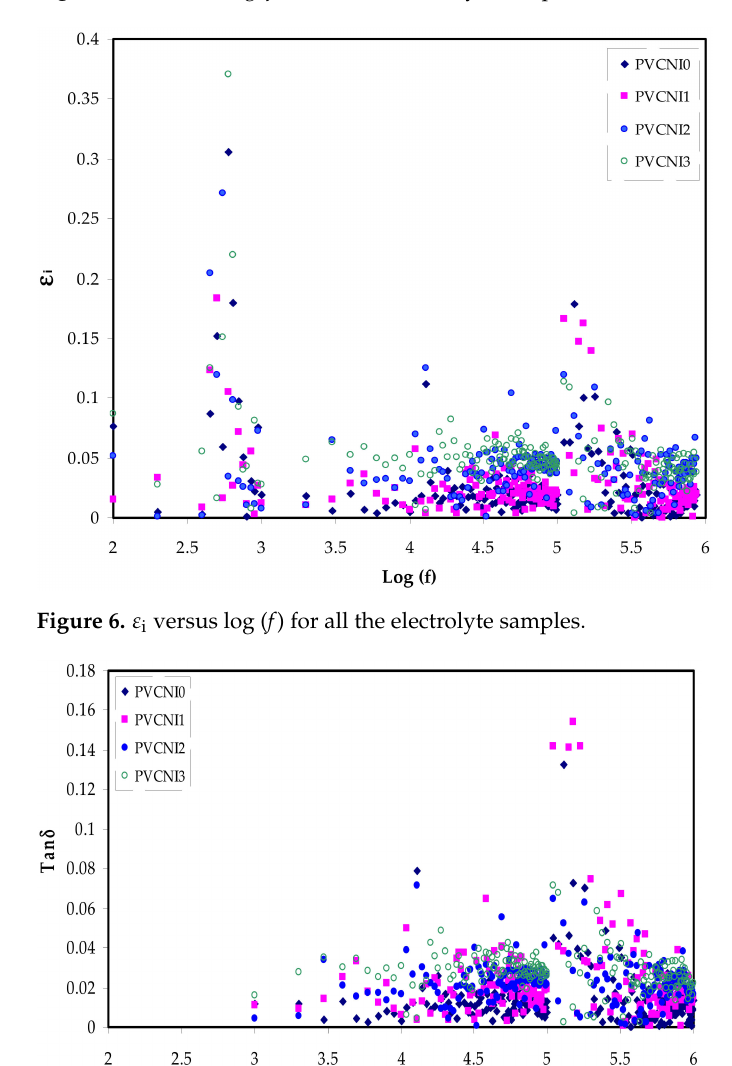
Figure 5. ε r versus log ( f ) for all the electrolyte samples.